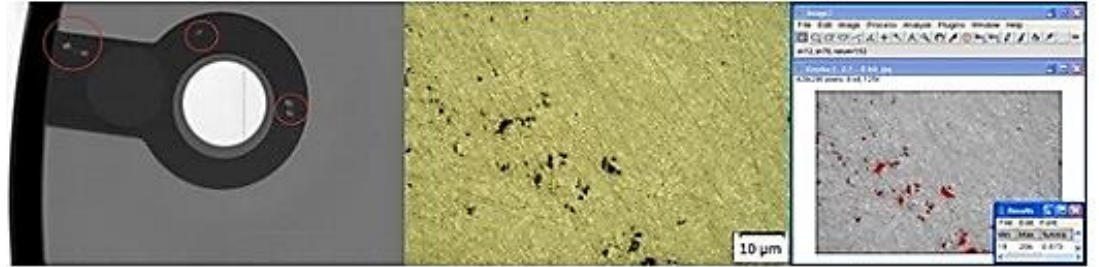
Figure 2. Analysis of specimen C.1.